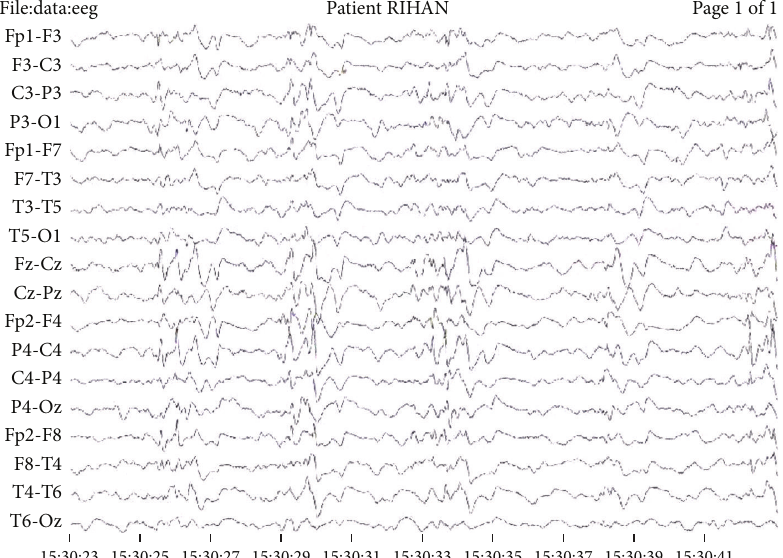
Figure 1: Twenty-second epoch of scalp electroencephalographic record revealing periodic bursts of high-amplitude, slow-wave complexes occurring every three to five seconds. Parameters are as follows: sensitivity 55 𝜇 V/mm, time constant 0.3 s, and high-frequency filter 70Hz.